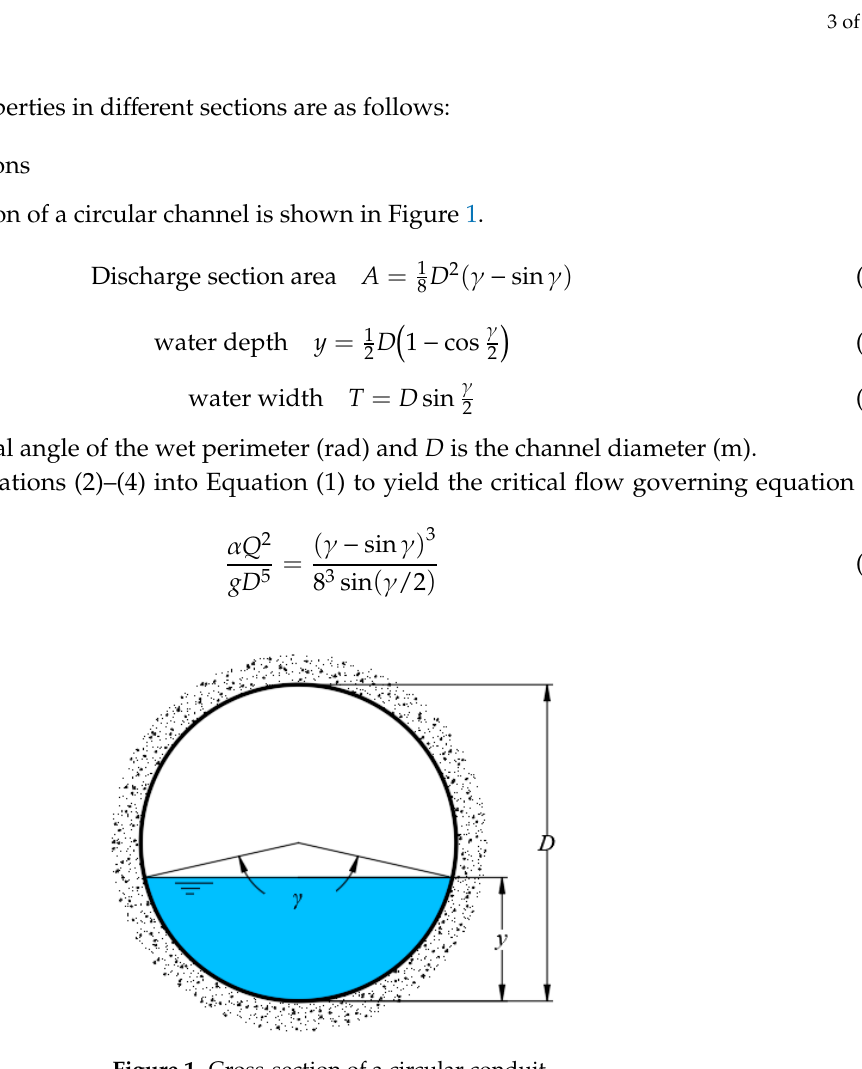
b Figure 2. Cross-section of an arched conduit (( a ) 0 ≤ y ≤ r , ( b ) r ≤ y ≤ 2 r )). Geometric properties of the arched section are: If 0 ≤ y ≤ r ,